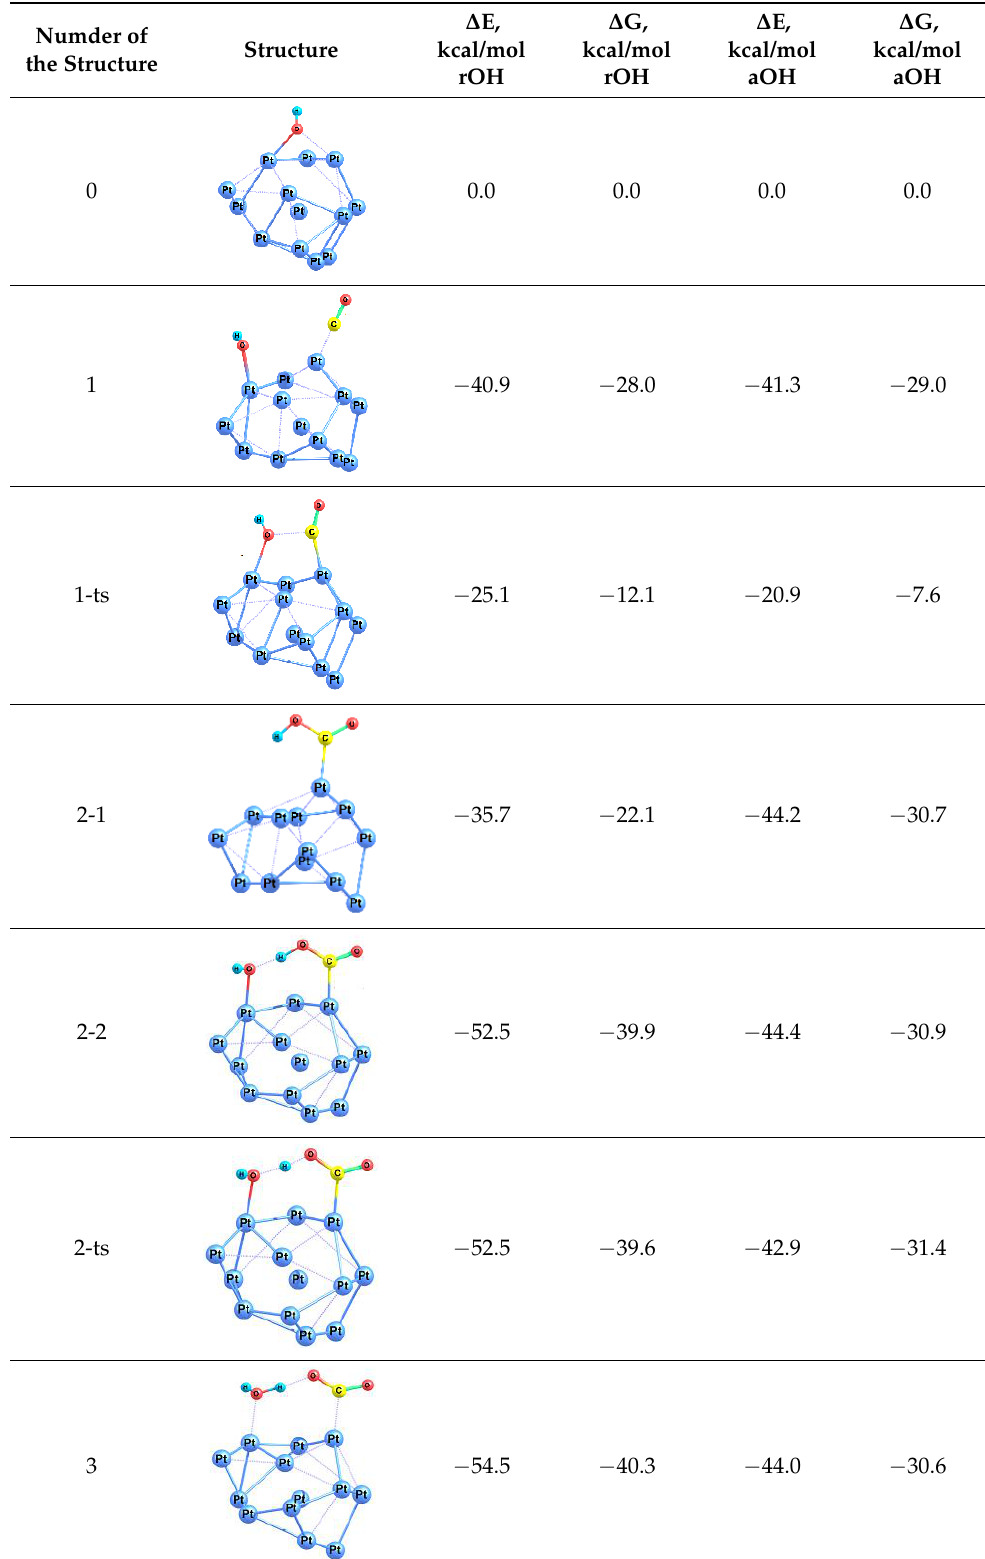
Table 4. The results of quantum-chemical calculations of the PES for reaction 22 with rOH and aOH in aqua media.